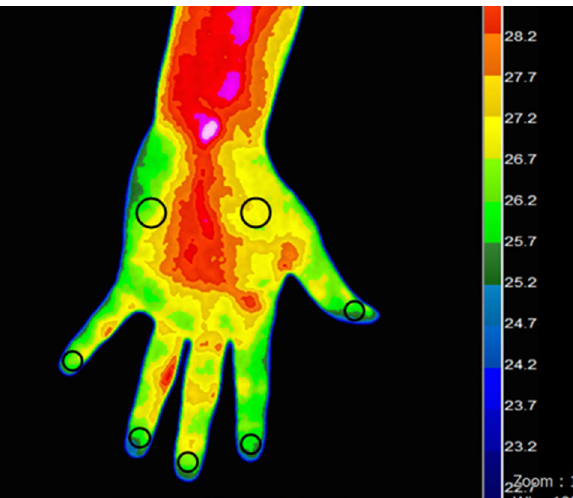
Figure 2. Digital infrared thermographic imaging and regions of interest of the palm area. The mean temperature is measured at the center of the finger pulp, thenar eminence, and hypothenar eminence (black circles).